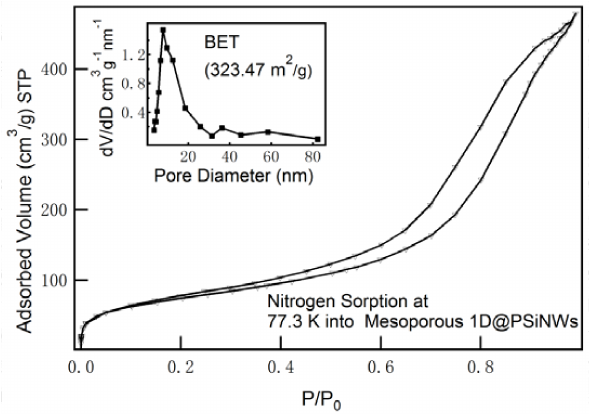
Figure 4. Nitrogen adsorption isotherm at 77.3 K (line, adsorption; triangular, desorption) and pore size distribution curve (inset) of 1D–PSiNWs depicted after fitting by the Barrett–Joyner–Halenda (BJH)